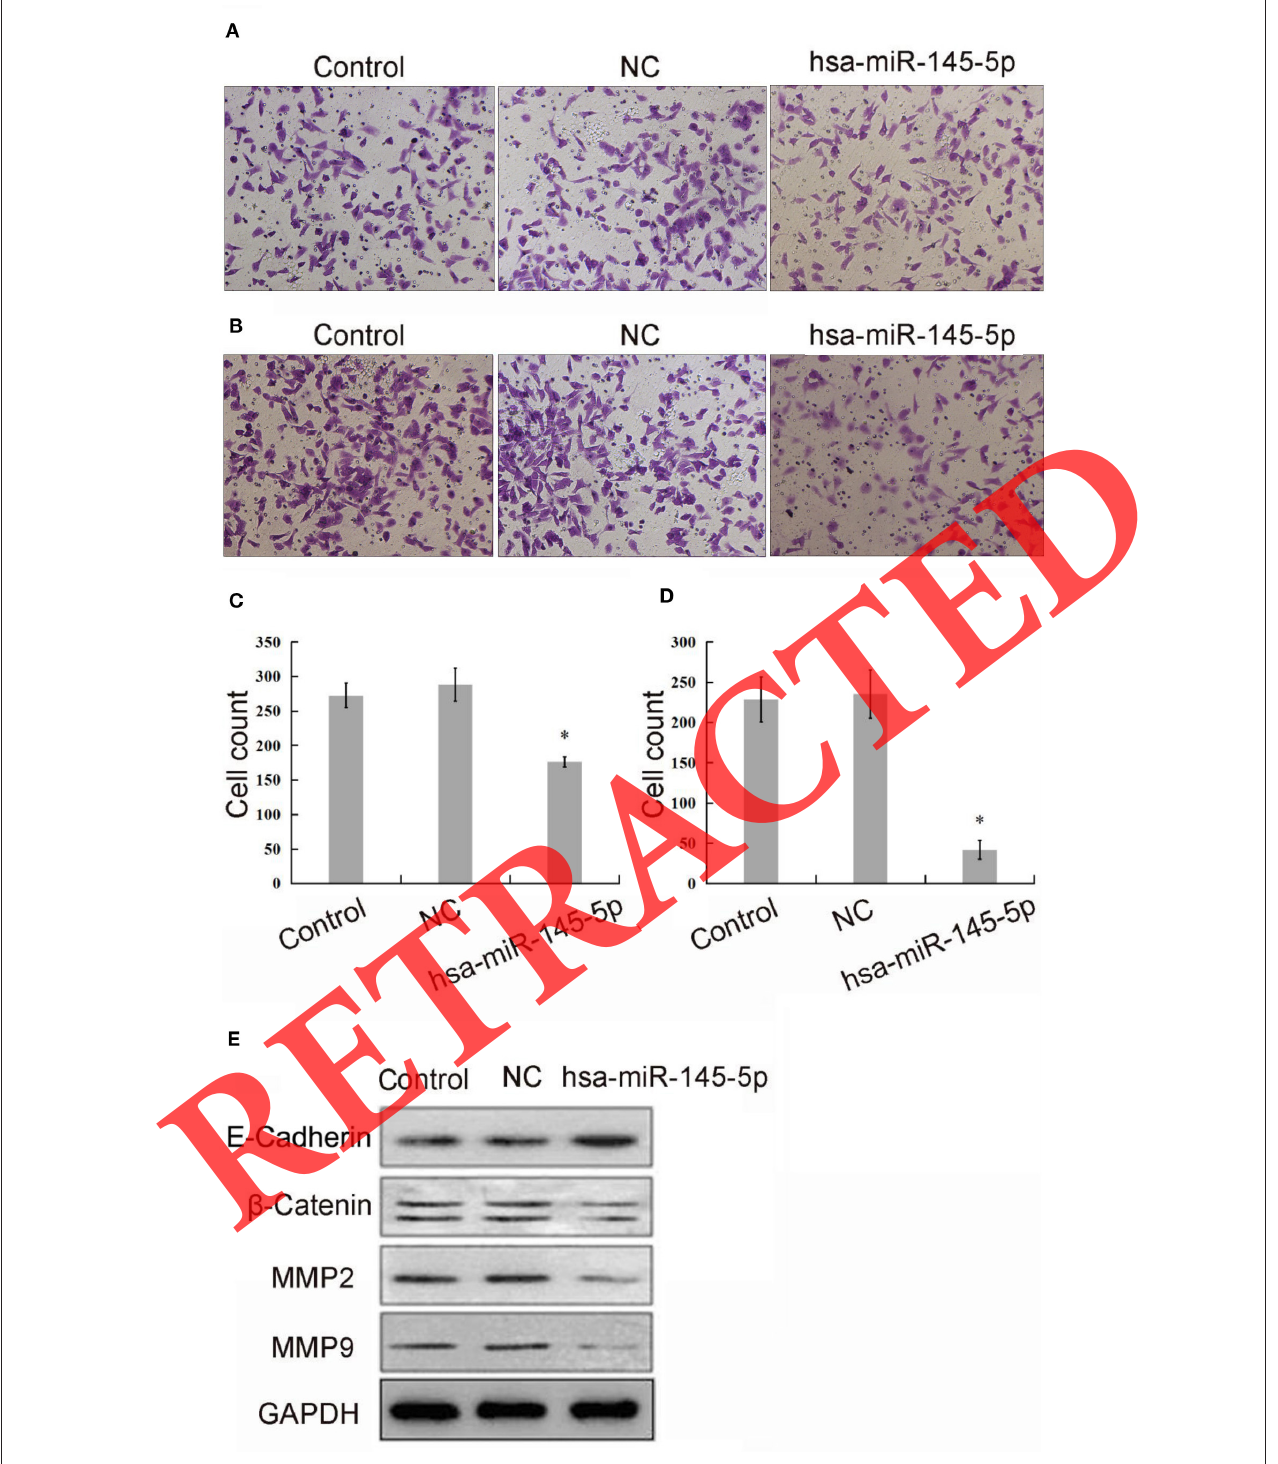
FIGURE 3 | Effect of miR-145-5p overexpression on cell migration and invasion. (A) A cell migration assay was performed on LNCaP cells overexpressing miR-145-5p. (B) A cell invasion assay was performed on LNCaP cells overexpressing miR-145-5p. (C) The number of migrated cells in the control, NC, and miR-145-5p groups; * P < 0.05 compared with the NC and control groups. (D) The number of invaded cells in the control group; * P < 0.05 compared with the NC and control groups. (E) The expression of E-cadherin, β -catenin, MMP2, and MMP9 protein detected by western blotting.